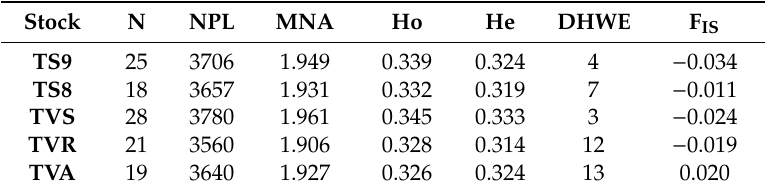
Table 1. Genetic diversity for five sea trout stocks from the southern Baltic Sea. N—number of individuals, NPL—number of polymorphic loci, MNA—mean number of alleles, H O —observed heterozygosity, H E —expected heterozygosity, DHWE—loci with deviation from H–W equilibrium after Bonferroni correction a population specific F IS.